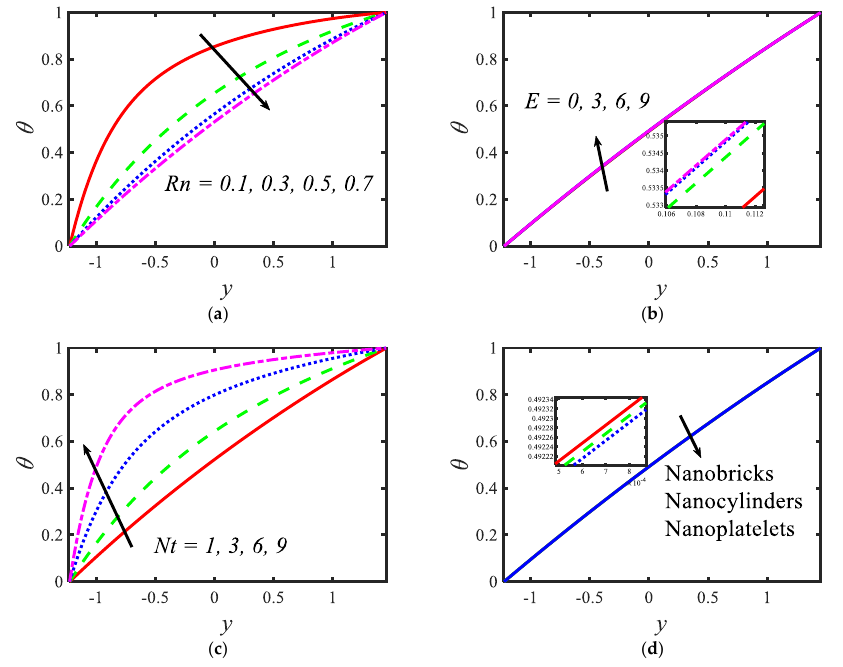
Figure 4. Variations in temperature profiles for ( a ) the radiation parameter, ( b ) Prandtl number, ( c ) thermophoresis parameter and ( d ) shape factor.